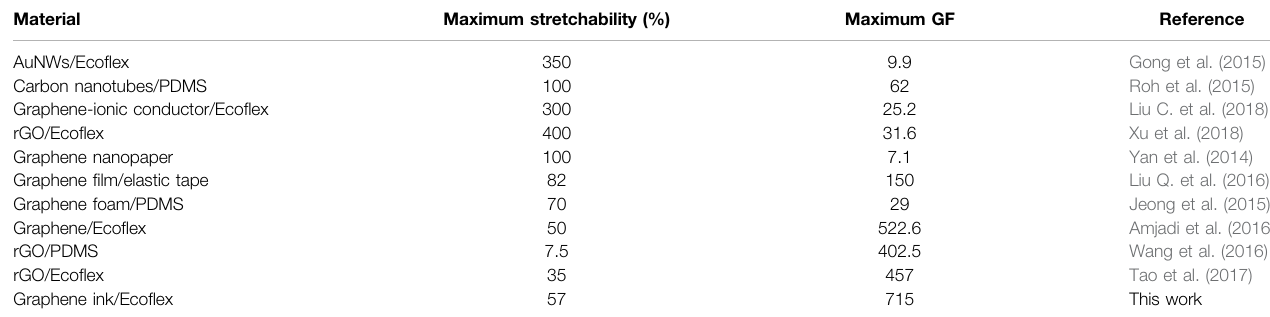
TABLE 1 | Comparison of sensing performance between other previously reported sensors and the sensor in this work.